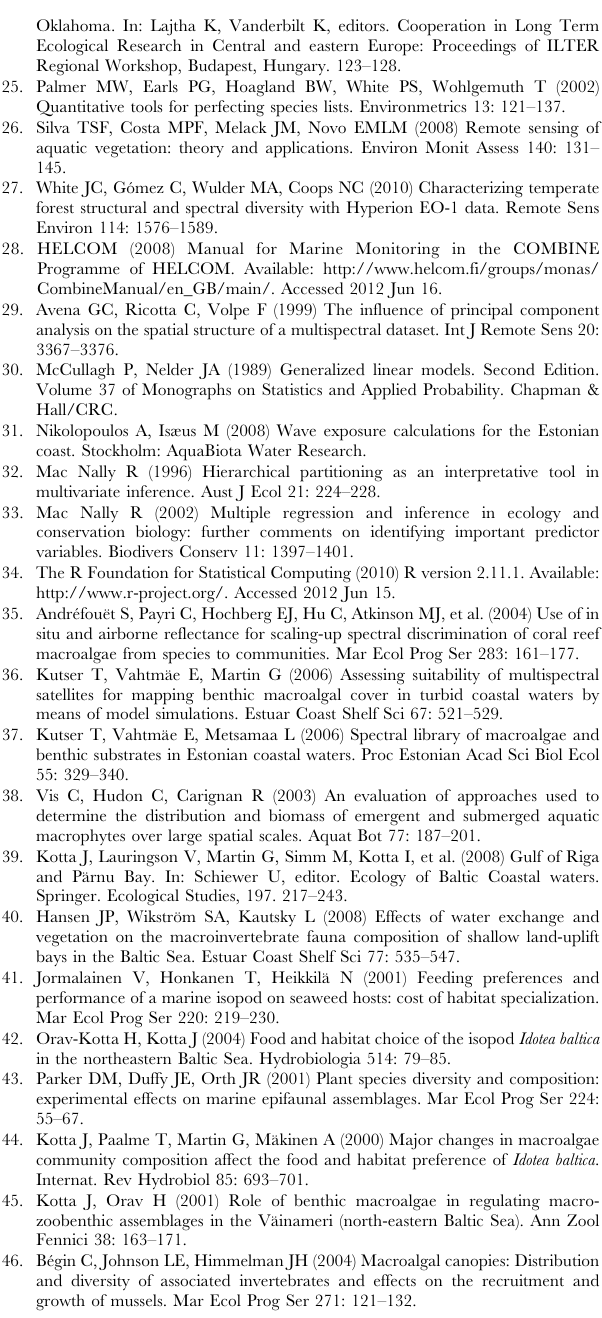
Table S2 Occurrences and biomasses of benthic species that were identified in biomass